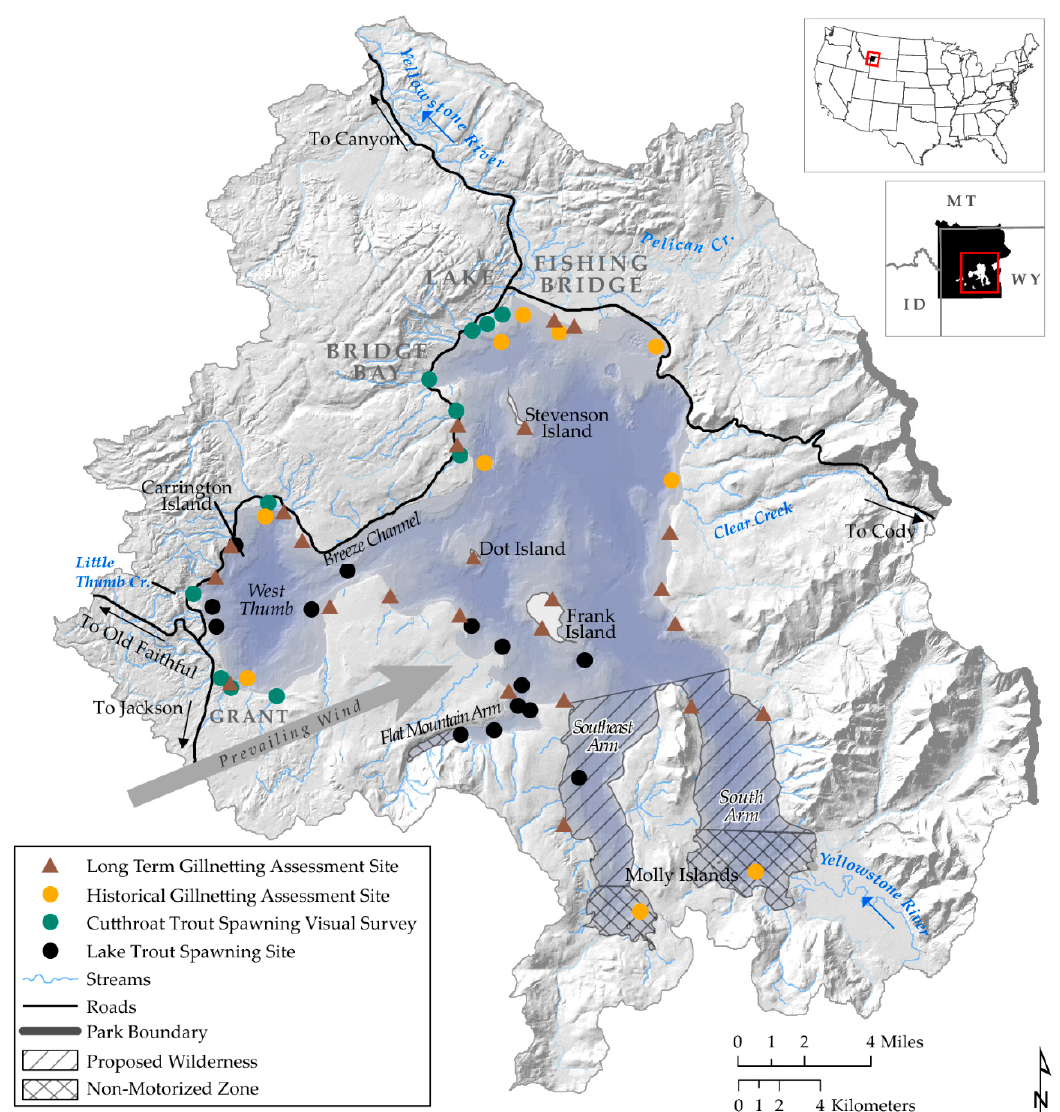
Figure 1. Yellowstone Lake within Yellowstone National Park in Northwestern Wyoming, USA, indicating locations of long-term gillnetting assessment sites for annual lake-wide monitoring of cutthroat trout and lake trout, historical gillnetting assessment sites that were sampled for cutthroat trout (prior to 2010), tributaries visually surveyed for spawning cutthroat trout each spring, and verified lake trout spawning sites [59]. Although 14 lake trout spawning sites are known in Yellowstone Lake, others probably exist [60]. Prevailing southwest (247°) winds and lake fetch during the autumn spawning period may preclude successful spawning along the eastern shore [61,62].